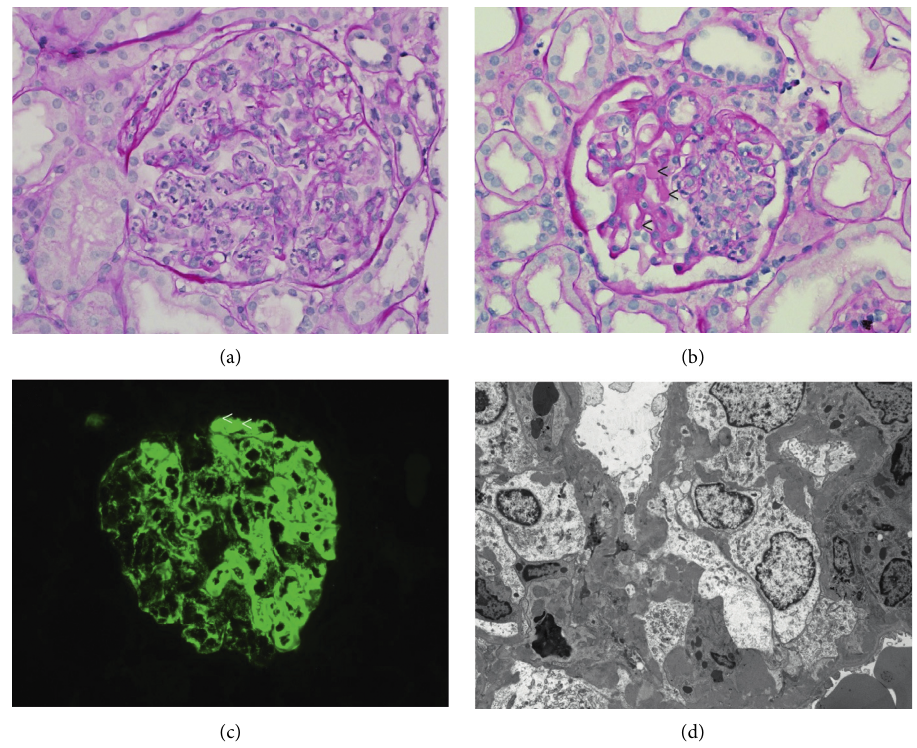
Figure 2: Findings of initial kidney biopsy: (a) a representative glomerulus with global endocapillary proliferation on periodic acid-Schiff stain; (b) a glomerulus with segmental mesangial and endocapillary proliferation (right side) and intracapillary pseudothrombi ( < ); (c) immunofluorescence staining of IgA shows global granular mesangial and capillary wall staining and a few intracapillary pseudothrombi ( < ); (d) electron microscopy shows many electron dense mesangial and subendothelial deposits with severe foot process effacement. Original magnification: 400X in (a–c) and 5000X in